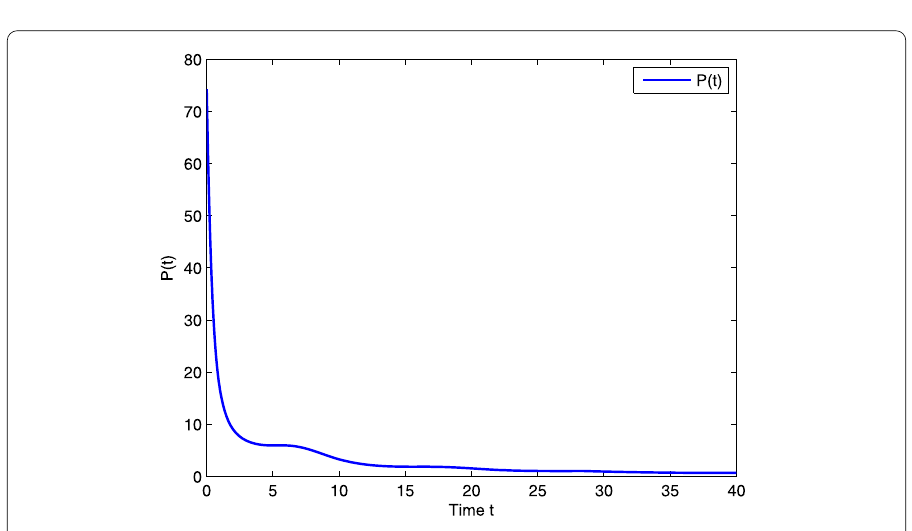
Figure 4 The trajectory of P ( t ) in Example